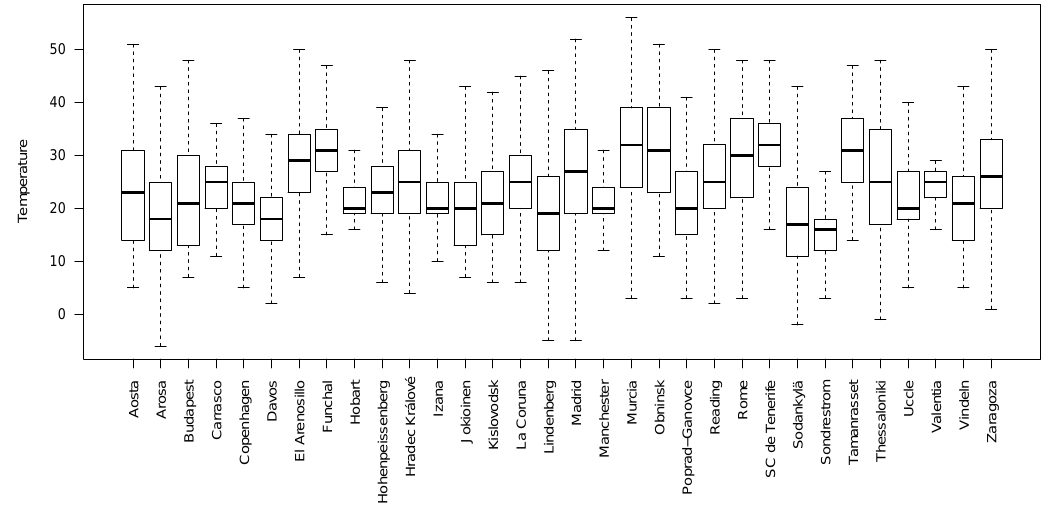
Figure 1. Statistics of each of the 32 stations used for the analysis of the operational instrumental temperatures. Median temperatures are represented by lines within boxes determined by the first and third quartiles. Whiskers represent Tukey’s limits. The first and third quartiles are always above 11 and below 39 ◦ C respectively.